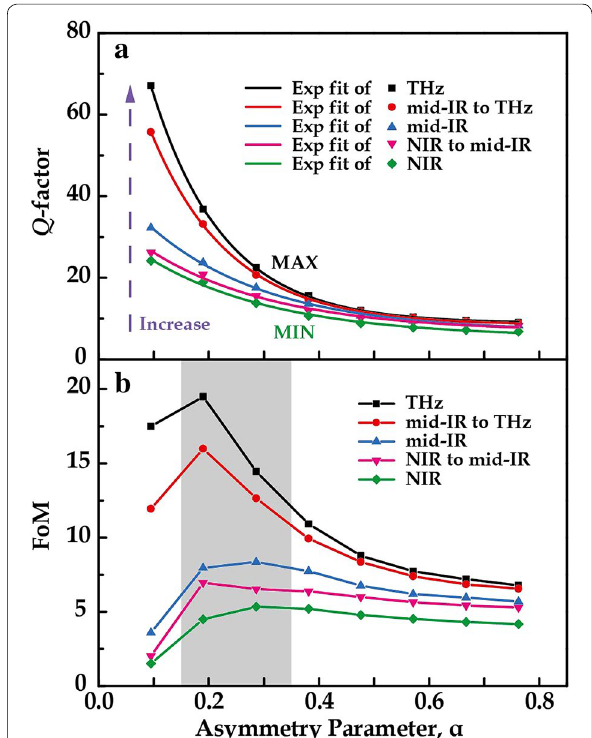
Fig. 4 a Numerically evaluated Q -factor and, b FoM plotted against the asymmetry parameter. The decay of the Q -factors with increas- ing asymmetry parameter at different regimes was fitted with an exponential decay